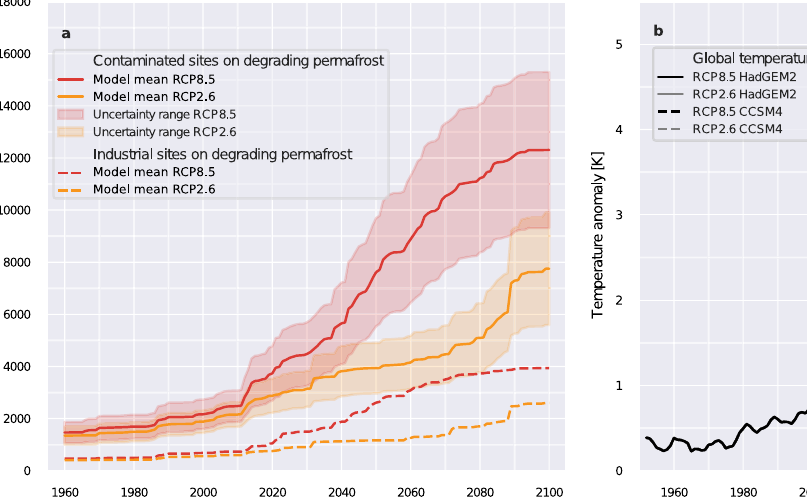
Fig. 6 | Industrial and contaminated sites affected by permafrost thaw under global warming conditions.a Number of industrial sites and number ofupscaled contaminated sites located in the permafrost dominated region modeled to be affected by permafrost thaw based on RCP 2.6 and RCP 8.5 warming scenarios (modelmeanfromtheCMIP5projectionsbasedonCCSM4andHADGEM2-ES).The